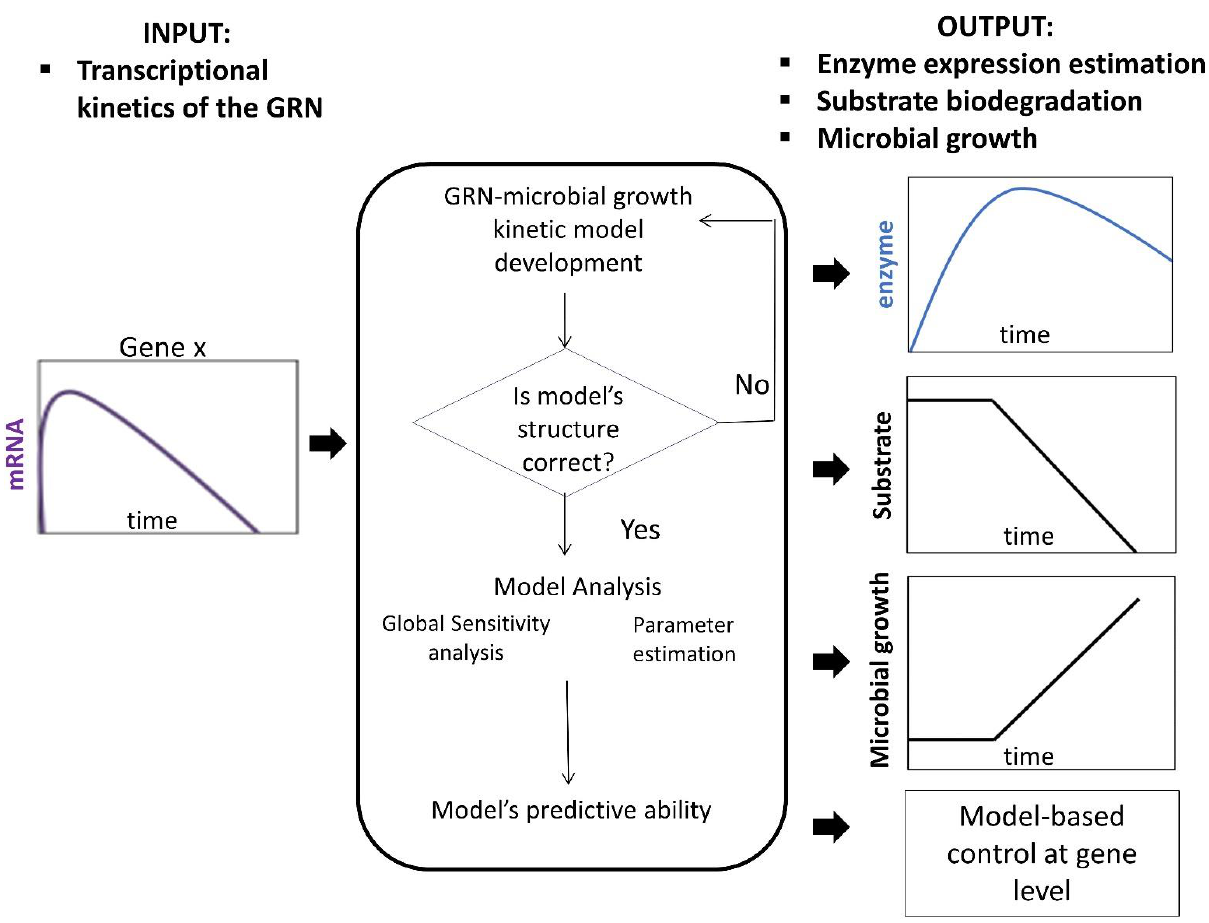
Figure 2. The framework reported in Tsipa et al. 2018 [11]. Transcriptional kinetics are the input for the gene regulatory network-microbial growth kinetic model to be built and validated. When the model is valid and has predictive capability, enzyme expression, substrate biodegradation and microbial growth can be predicted.